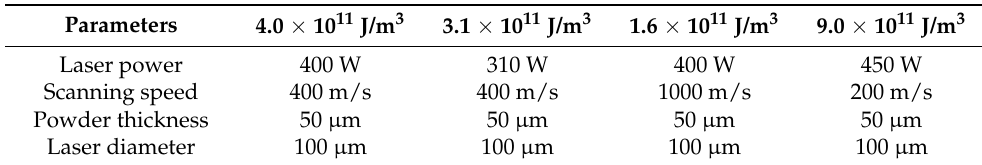
Table 2. The process parameters of selective laser melting